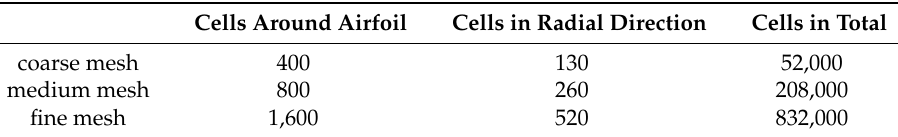
Table A1. Number of cells used in the mesh study.